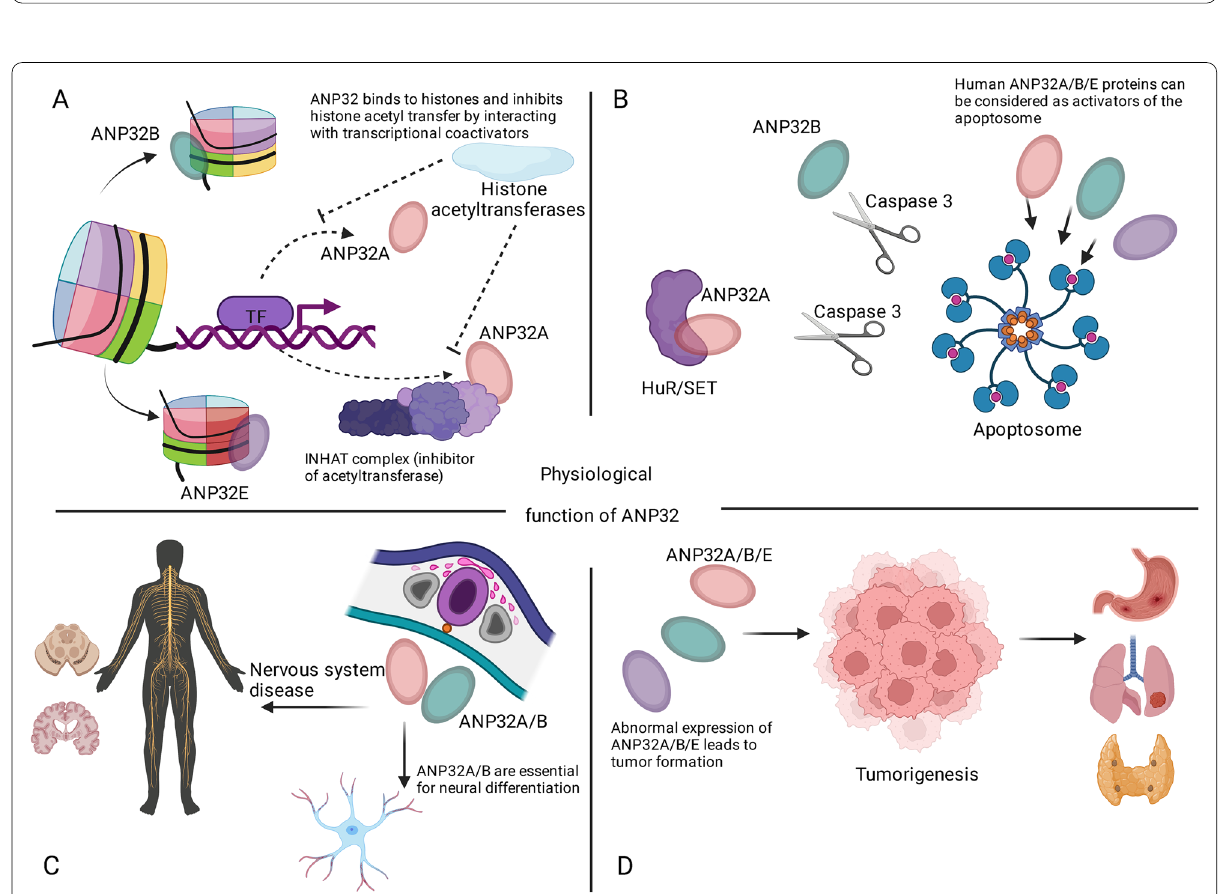
Fig. 2 ANP32 family proteins involve in various physiological functions. A Chromatin remodeling; B Apoptosis; C Regulation of neural development; D Malignant